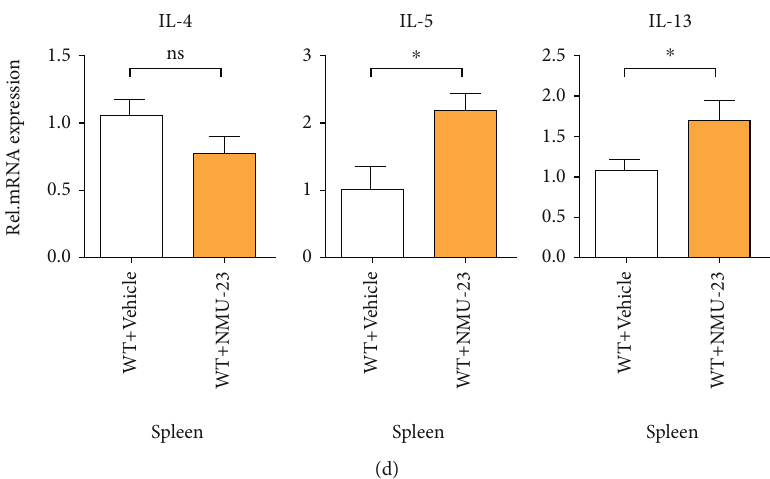
Figure 3: Th2-related cytokines and nuclear transcription factor mRNA expression levels were upregulated by NMU-23 treatment. (a, b) mRNA expression of FoxP3, Gata3 (a), IL-4, IL-5, and IL-13 (b) in the joint of vehicle- and NMU-23-treated mice. (c, d) mRNA expression of FoxP3, Gata3 (c), IL-4, IL-5, and IL-13 (d) in the spleen of vehicle and NMU-23-treated mice. Data are shown as mean ± SEM ( ∗ P < 0 : 05 , ∗∗ P < 0 : 01 , ∗∗∗ P < 0 : 001 , and ∗∗∗∗ P < 0 : 0001 determined by Student ’ s t